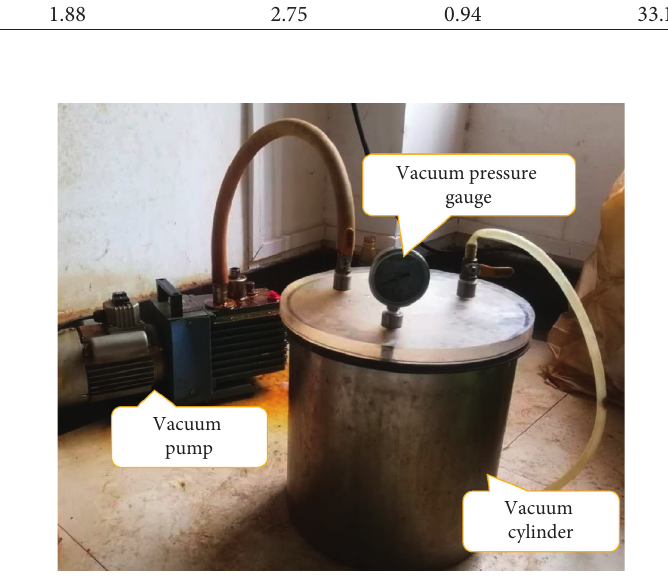
Figure 6: The device for evacuating